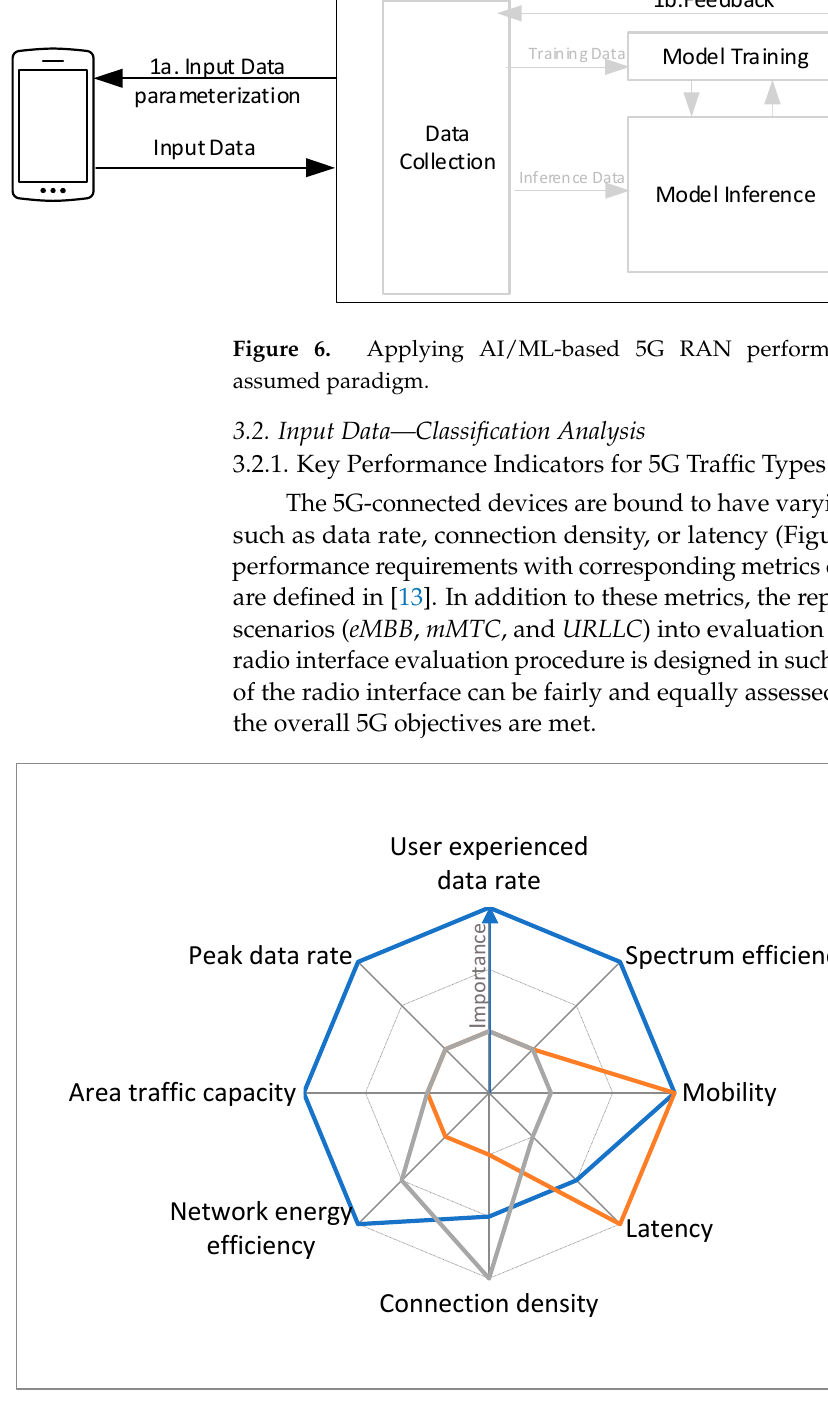
Figure 7. The importance of key capabilities in different 5G usage scenarios [3].